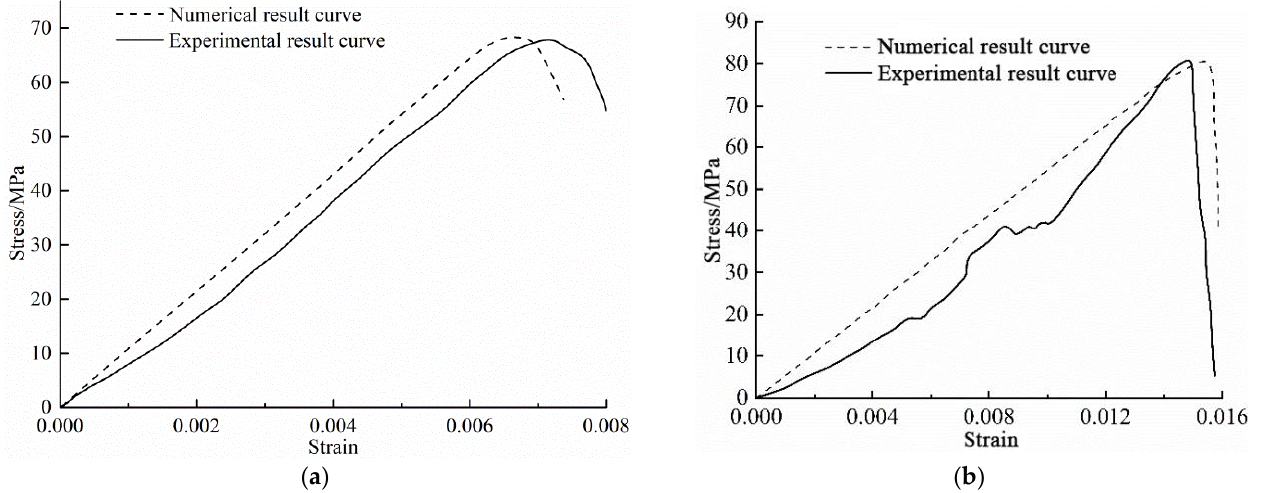
Figure 7. Real jointed rock mass specimen and numerical one: ( a ) real specimen; ( b ) numerical model.